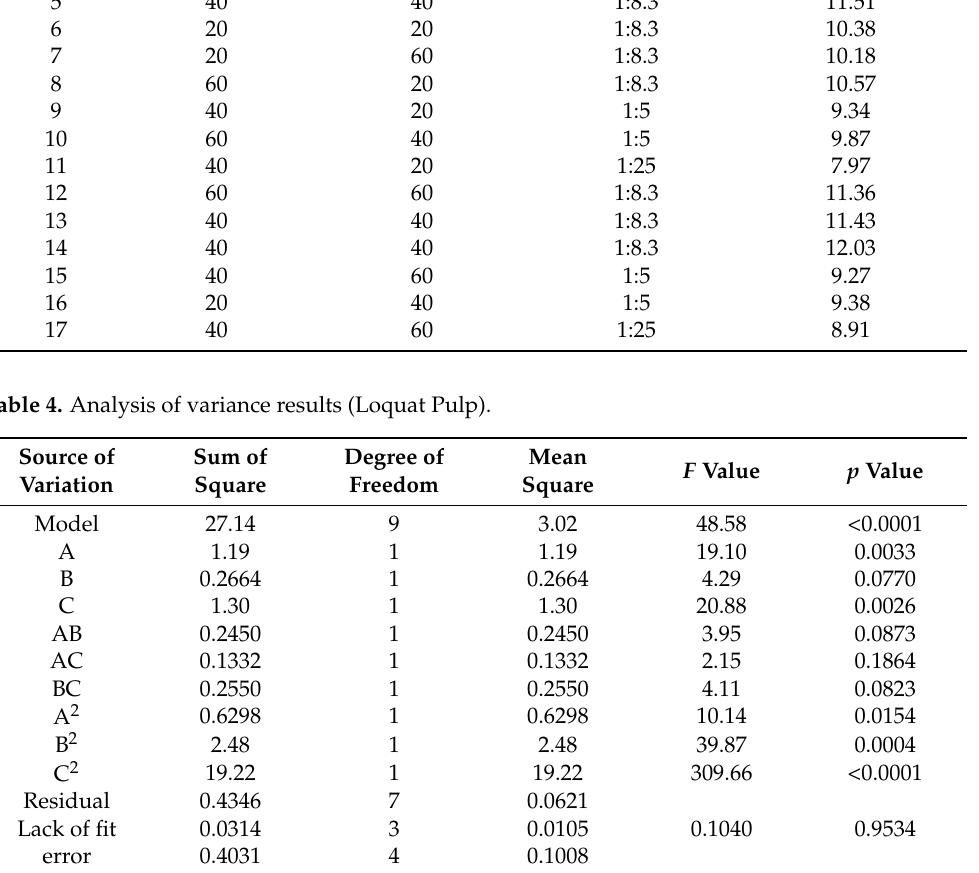
Table 3 data were fitted using Design-Expert 8.0.6 software to obtain a quadratic multinomial regression equation with total triterpene content (Y) as the objective function: Y = 11.78 + 0.3850A + 0.1825B + 0.4025C + 0.2475AB − 0.1825AC − 0.2525BC − 0.3867A 2 − 0.7667B 2 − 2.14C 2 (3) According to the ANOVA analysis in Table 4, the model was F = 48.58, p < 0.0001, and the established model was significant ( p < 0.0001) and statistically significant. As shown in Table 4, the misfit term is not significant (F = 0.1040, p = 0.9534), which indicates that the model has sufficient predictive correlation to explain the correlation between the independent variable and the dependent variable. In the first term, A and C were significant ( p < 0.05), and in the second term, A 2 , B 2 , and C 2 were significant ( p < 0.05). The R 2 value of 0.9842 indicates the reasonable fit of the model and experimental data, and the values of AdjR 2 (0.9640) and Pre R 2 (0.9589) indicate a good correlation between experimental and predicted values, indicating that the model is significant and statistically